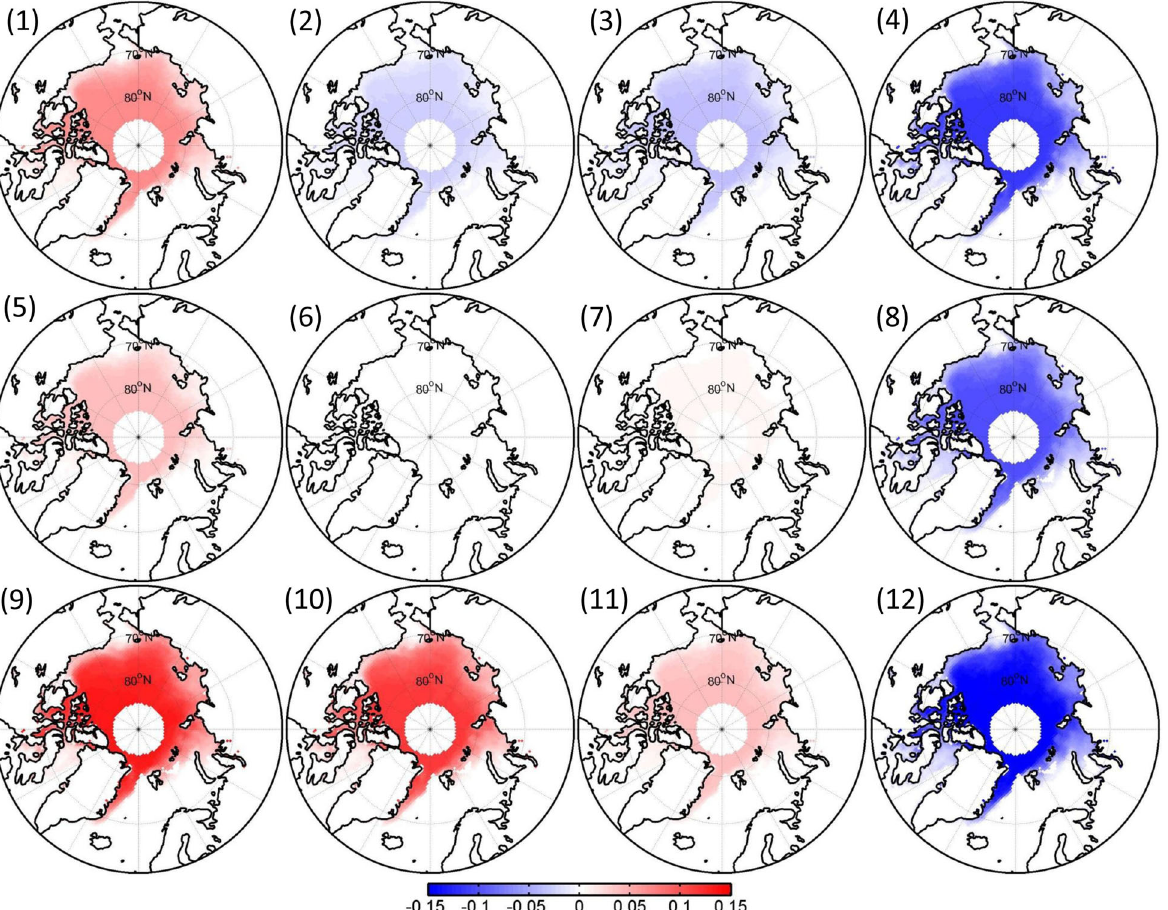
Fig. 4 Contribution from the dynamic components to the trends in the number of August – October Arctic sea ice days for each of the 12 SOM nodes (units: day yr − 1